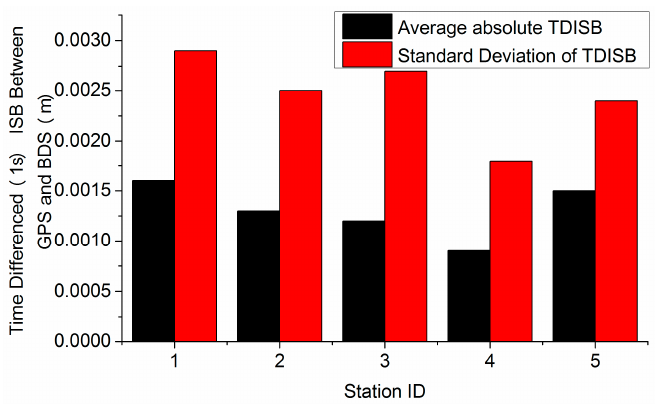
Figure 1. Statistics of time-differenced inter-system bias (TDISB) for five sites on DOY 353 in 2015.